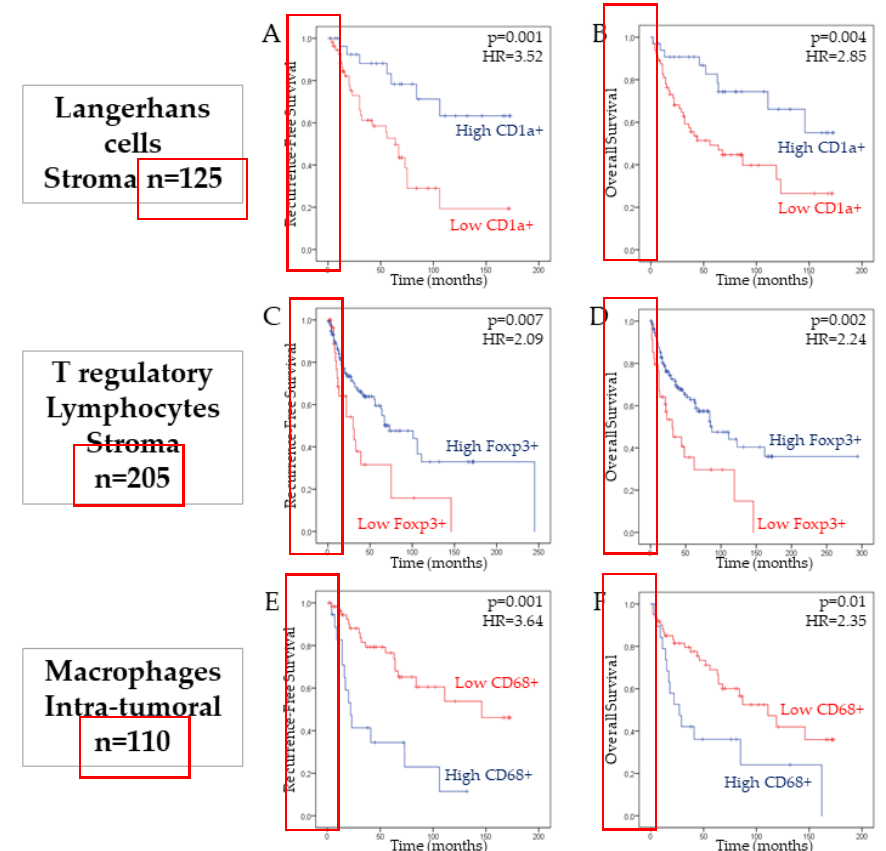
Figure 2. Association between CD1a + Langerhans cells, FoxP3 + Treg and CD68 + macrophages infiltration and patient survival in head and neck squamous cell carcinomas (HNSCC). Kaplan–Meier curves of the recurrence-free survival (RFS) ( A , C , E ) and overall survival (OS) ( B , D , F ) of patients with HNSCC in the stromal compartment, according to the number of CD1a + Langerhans cells ( p = 0.001 and p = 0.004, log-rank test) and Foxp3 + Treg cells ( p = 0.007 and p = 0.002, log-rank test). The intra-tumoral number of macrophages is associated with a lower RFS ( p = 0.001) and OS ( p = 0.01, log-rank test) of HNSCC patients.